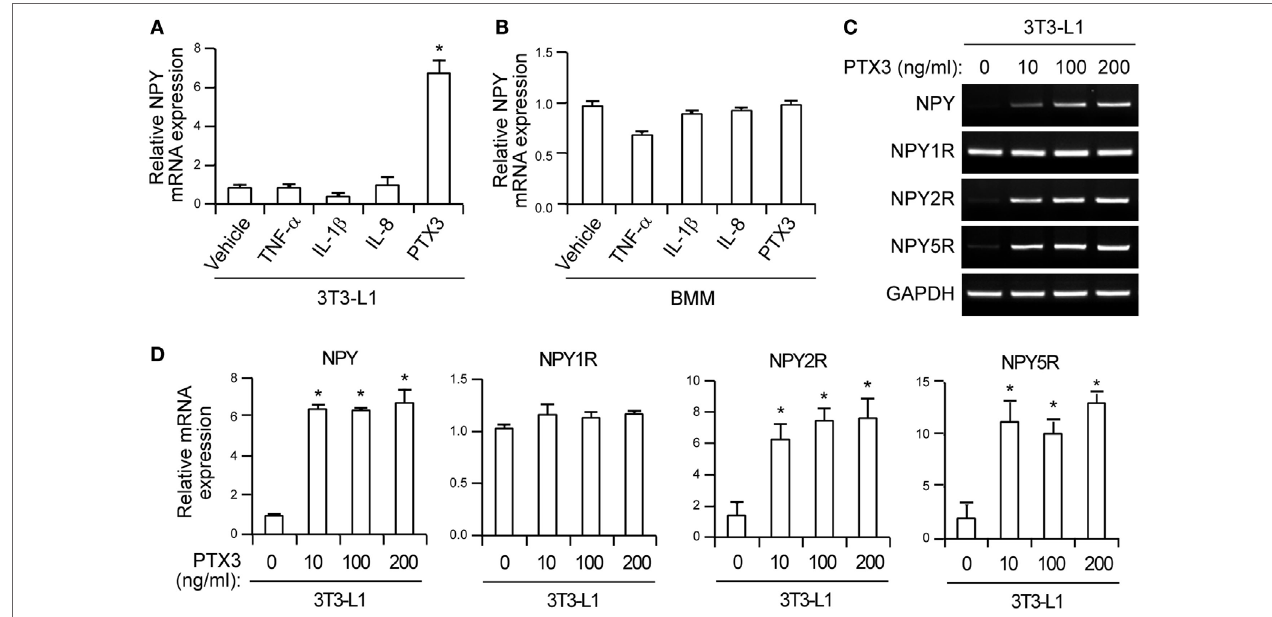
FigUre 2 | Pentraxin 3 (PTX3) induces neuropeptide Y (NPY) and neuropeptide Y receptor (NPYR) expression in murine preadipocytes. (a,B) 3T3-L1 cells (a) and bone marrow-derived macrophages (B) were treated with the tumor necrosis factor- α , interleukin-1 β , IL-8 cytokines, and PTX3 (10 ng/ml) for 24 h. The mRNA expression level of NPY was determined using quantitative real-time PCR. GAPDH was used as an internal control (mean ± SD). Data values are the fold-changes of the mean vehicle control value ( n = 4). (c) Effects of PTX3 on NPY/NPYR expression in 3T3-L1 cells. 3T3-L1 cells were incubated with the indicated concentration of PTX3 for 24 h and the mRNA expression of NPY, NPY1R, NPY2R, and NPY5R were determined using RT-PCR. GAPDH was used as an internal control. (D) PTX3 upregulates the expression of NPY, NPY2R, and NPY5R. The NPY, NPY1R, NPY2R, and NPY5R mRNA levels in 3T3-L1 cells treated with the indicated concentrations of PTX3 for 24 h were quantified using quantitative real-time PCR ( n = 4). Data are representative of three independent experiments. Data are the fold-changes in the mean vehicle control value and represent the mean ± SD. * p < 0.05 compared with the vehicle control. p values were calculated using Kruskal–Wallis